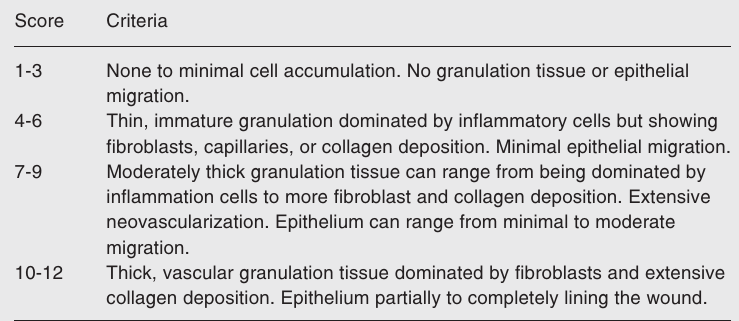
Table 1. Histological